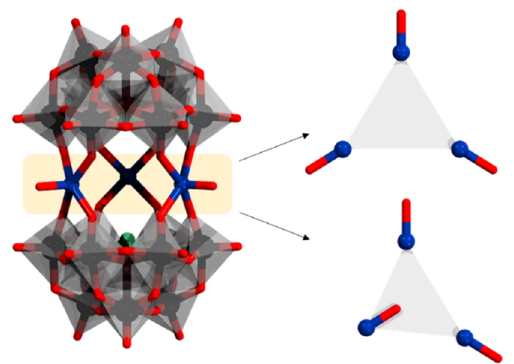
Figure 7. [(V IV O) 3 ( α -AsW 9 O 33 ) 2 ] 12 − ( left ) and the two different orientations of the cationic {VO} ( right ). Color code: X = green (but covered), V = dark blue, {WO 6 } = gray octahedra, W = black, and O = red.